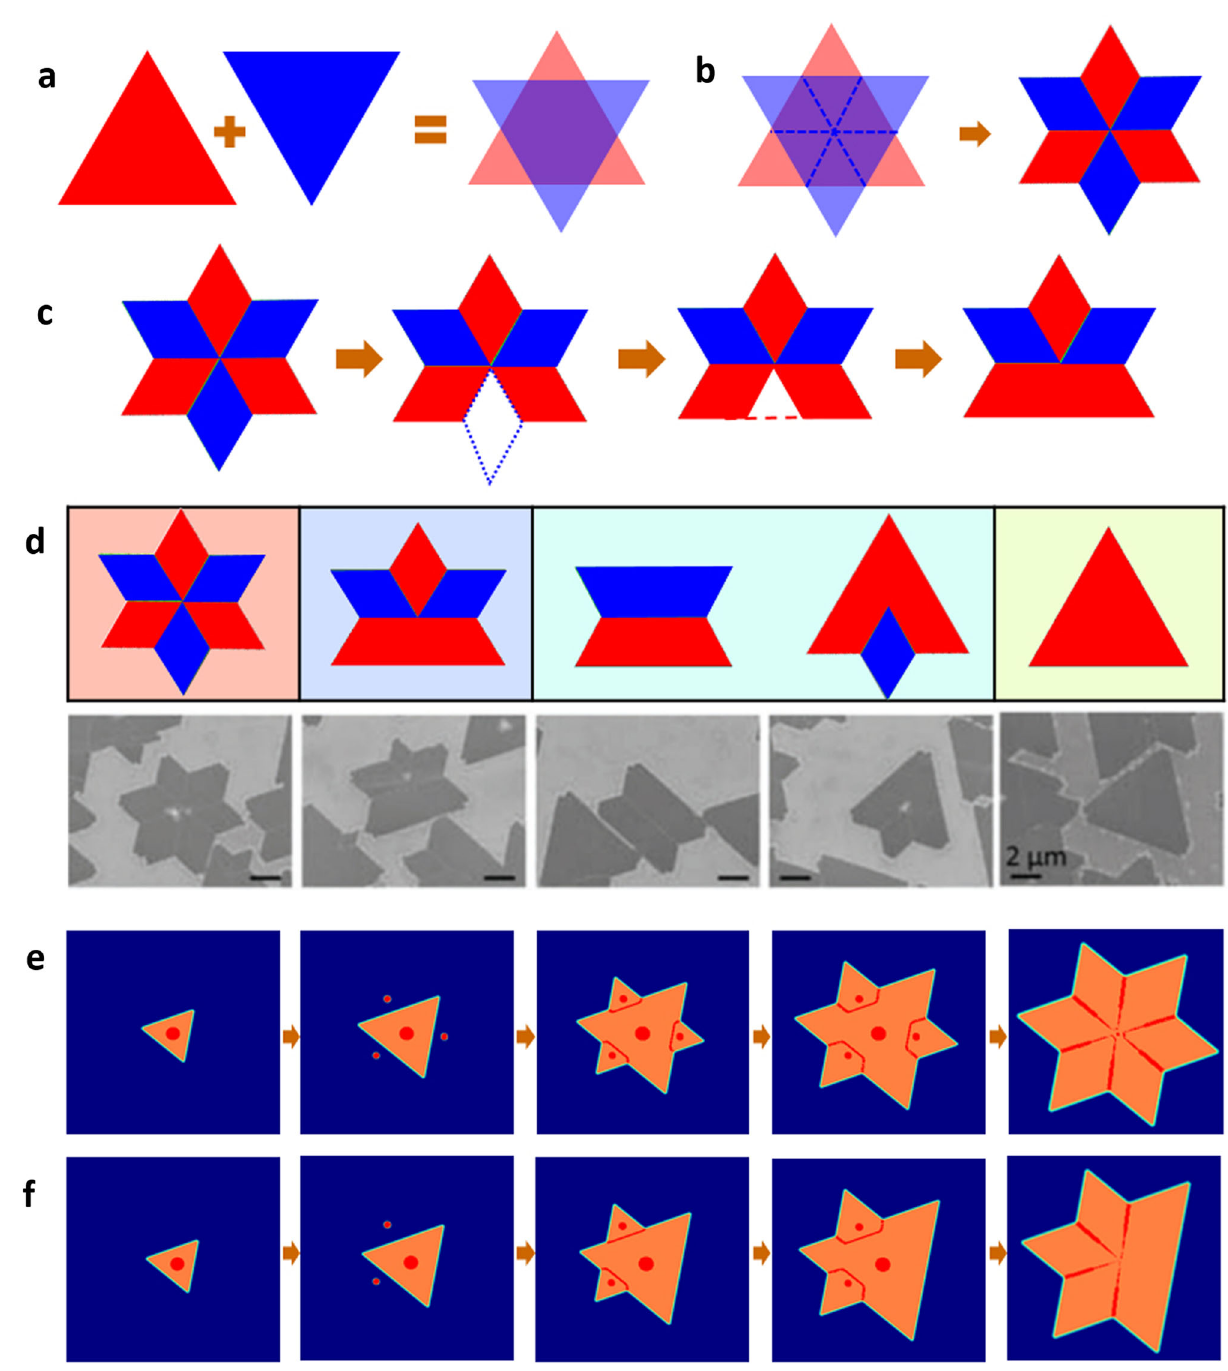
Fig. 3 Formation of polycrystalline threefold symmetric 2D material islands from the coalescence of an arbitrary number of misaligned triangular grains with 60 o misorientation angles on a two- or six-fold symmetric substrate. a , b Schematics showing how to construct a polycrystal with the maximum number of convex vertices. c Schematics showing the method of constructing polycrystals with fi ve convex vertices from the most complex polycrystalline 2D island. d A predicted library of 2D polycrystals of family-III/II or -III/VI. The lower panel shows the experimental observation of polycrystalline hBN islands grown on a Cu(110) surface. Reproduced from ref. 25 with permission from the Royal Society of Chemistry. e , f PFT simulation on the growth process of a polycrystalline island with six and fi ve convex vertices, respectively. The fi fth panels in e , f are zoomed out for a better